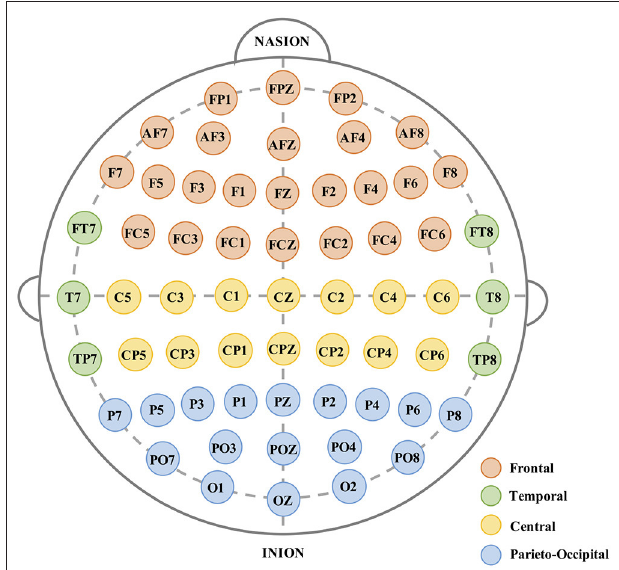
FIGURE 2 | Placement of the recorded 61-channel electroencephalogram (EEG).